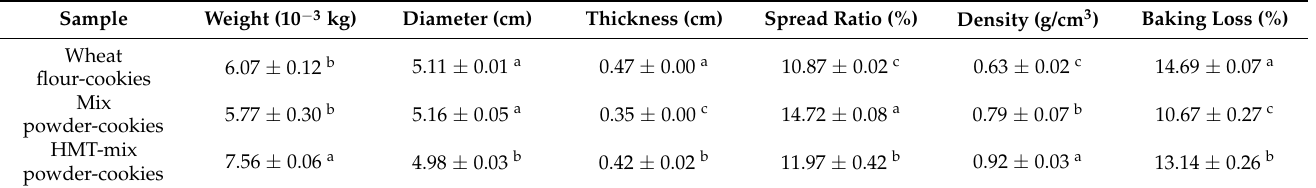
Table 7. Physical properties of cookies made from wheat four, mix powder and HMT-mix powder. Sample